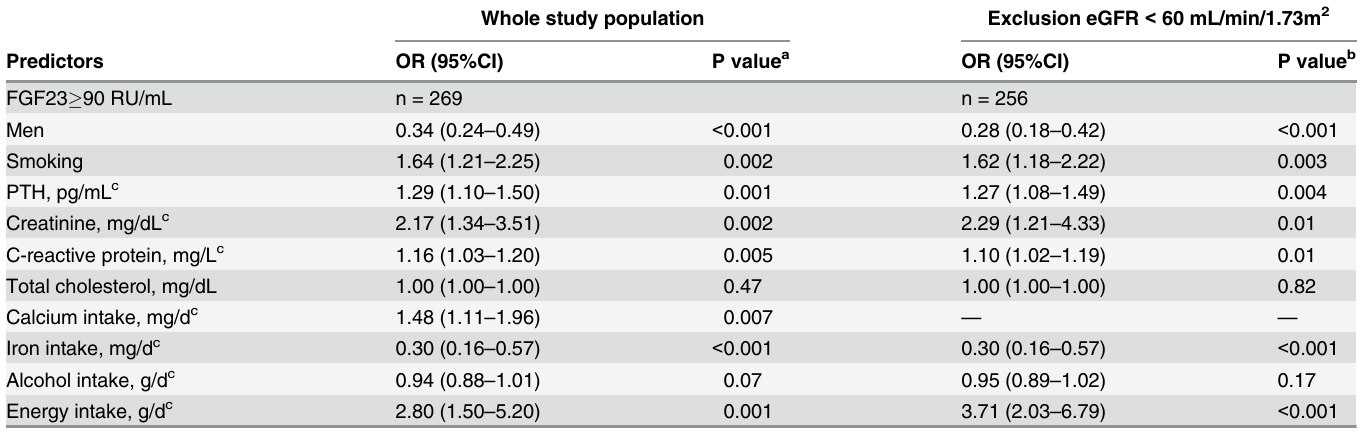
Table 4. Odd ratios (OR) and 95% Confidence Intervals (CI) for the associations between high FGF23 ( > = 90 RU/mL) and the best subset of its sig- nificant correlates, mutually adjusted for each